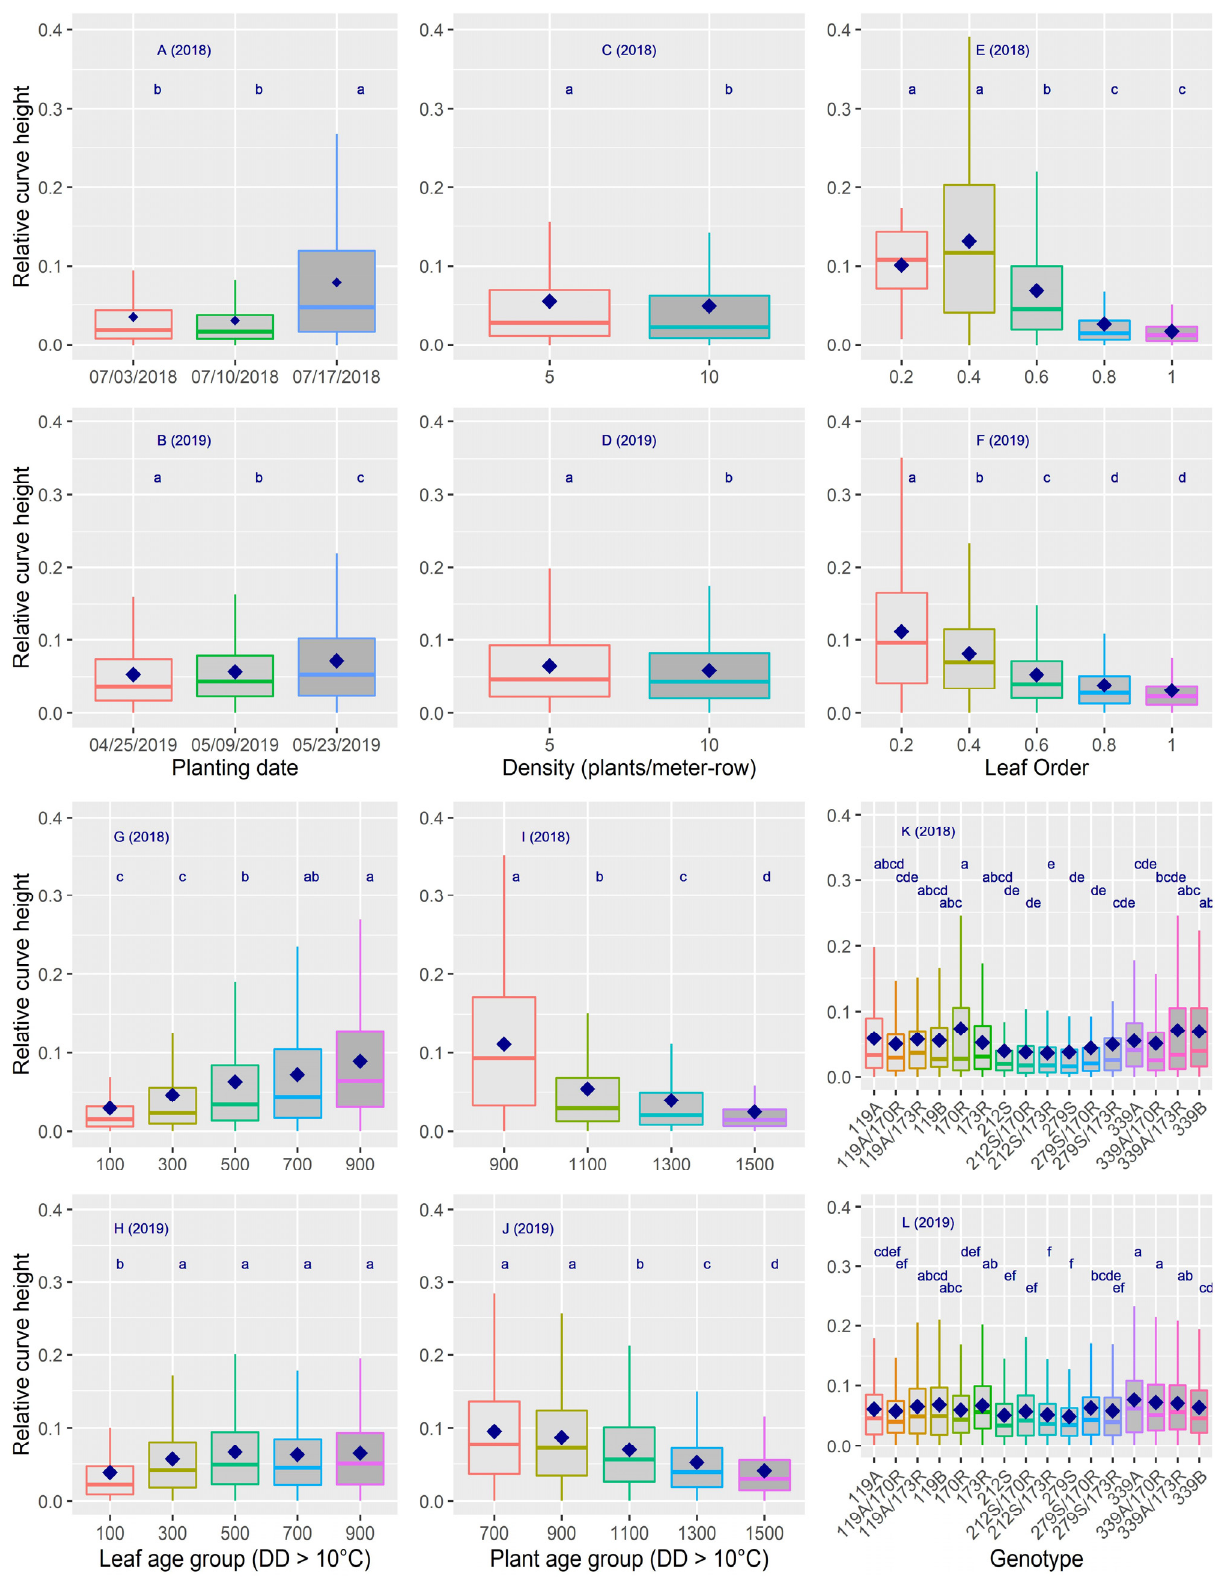
Figure 6. Relative curve height in relation to planting date ( A ): 2018 and ( B ): 2019, density ( C ): 2018 and ( D ): 2019, leaf order ( E ): 2018 and ( F ): 2019, leaf age ( G ): 2018 and ( H ): 2019, plant age ( I ): 2018 and ( J ): 2019, and genotypes ( K ): 2018 and ( L ): 2019. For each plot, categories having the same lowercase letter are not significantly different from each other at 0.05 with Tukey’s HSD multiple comparison